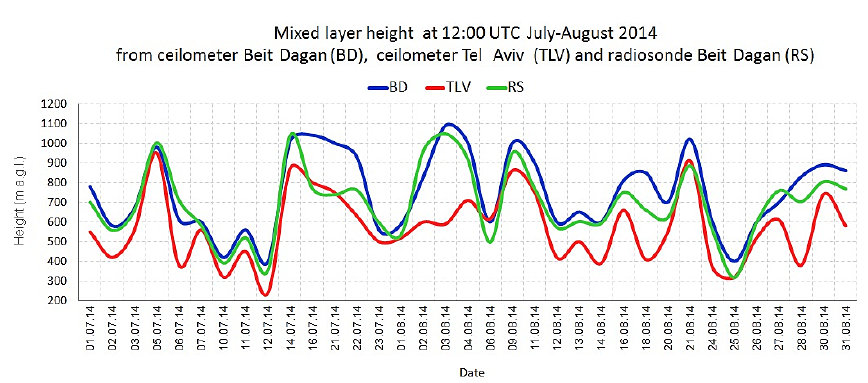
Figure 8. The diurnal MLH at 12:00UTC between July and August 2014, from ceilometers at TLV and BD sites, compared to the MLH derived from the radiosonde. The evaluation was based on 35 days between 1 July and 31 August 2014 with full data from the three instruments.